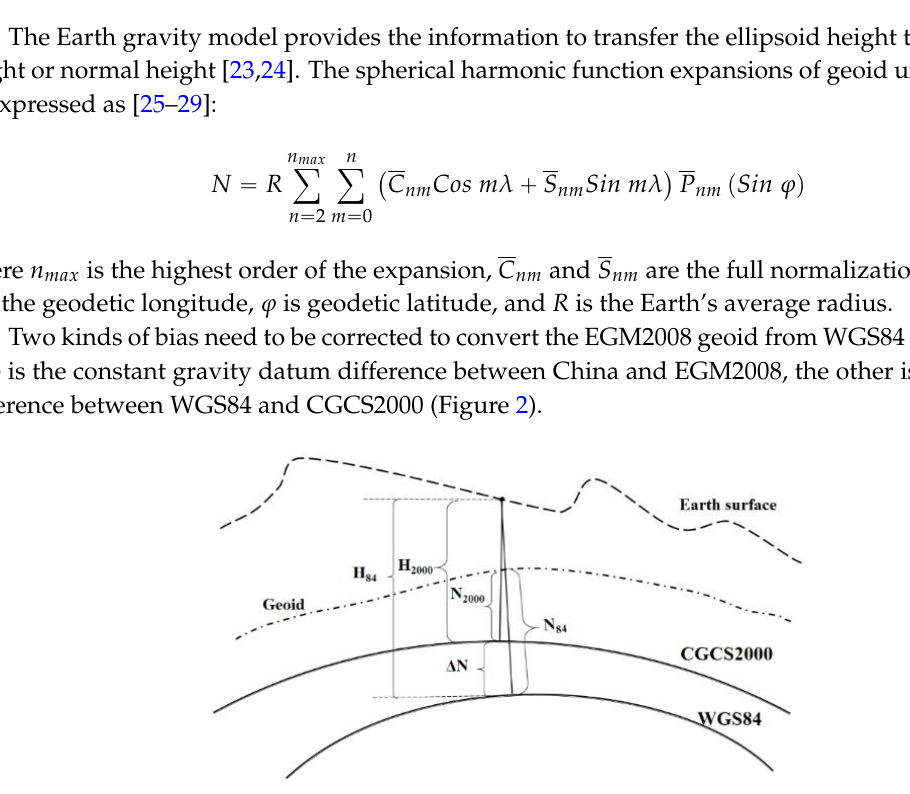
Figure 2. Geoid bias between CGCS2000 and WGS84.